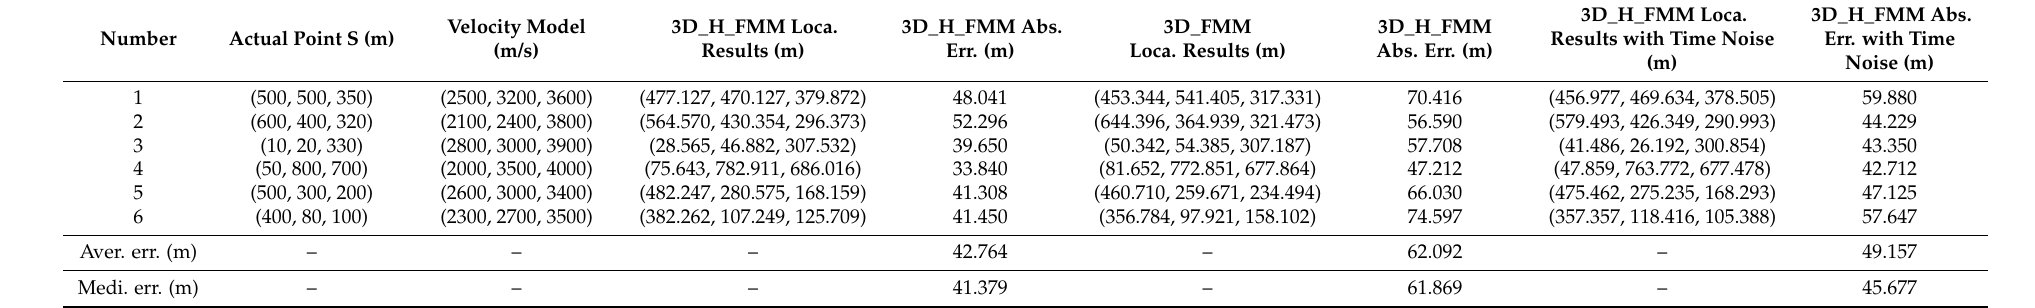
Table 8. The localization results of microseismic sources using travel times (calculated by 3D_H_FMM and 3D_FMM) and their noise-laden travel times with Case D: large-scaled inhomogeneous velocity